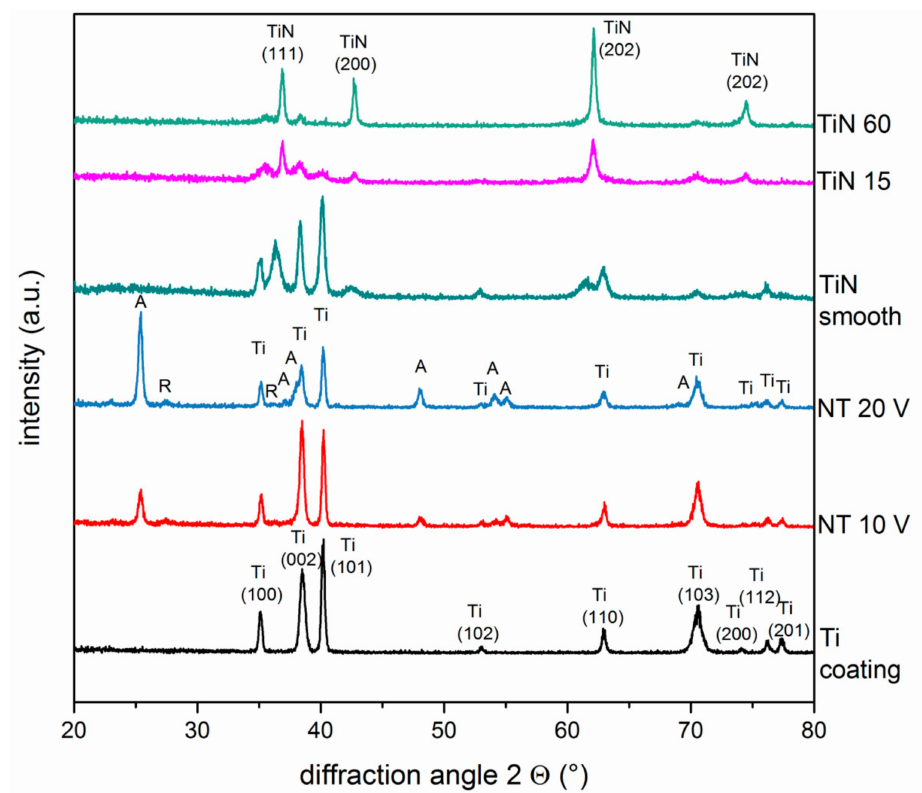
Figure 3. X-ray di ff raction (XRD) analysis. X-ray di ff raction patterns of an untreated Ti layer, smooth and nanorough TiN coatings on glass slides, as well as the TiO 2 nanotube arrays after annealing at 450 ◦ C for 3 h. The di ff erent phases are marked as follows: A: anatase, R: rutile, Ti: Ti coating, TiN: TiN coating. Ti and TiN lattice planes are marked with the corresponding Miller